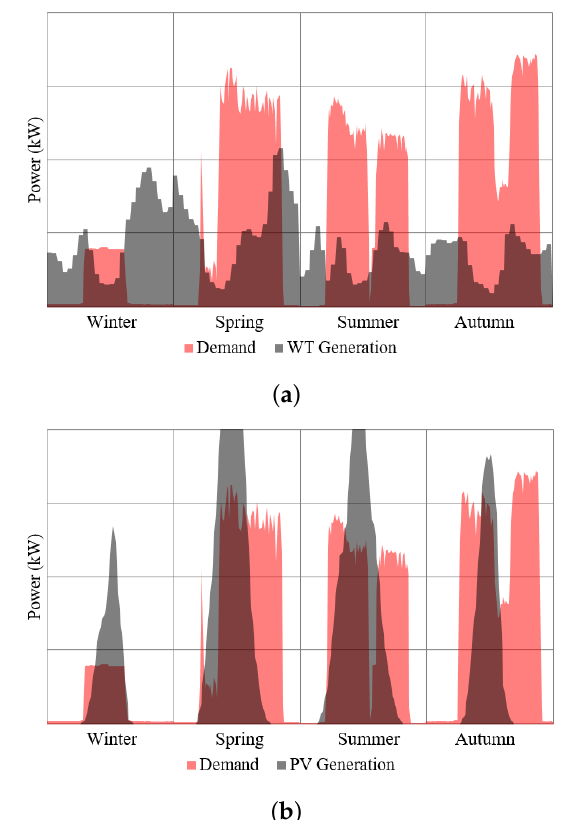
Figure 11. Normalized renewable energy generation and inflexible electricity demand of a weekday for each season; The overlapped area represents on-site utilization. ( a ) Wind turbine (WT) generation; ( b ) PV